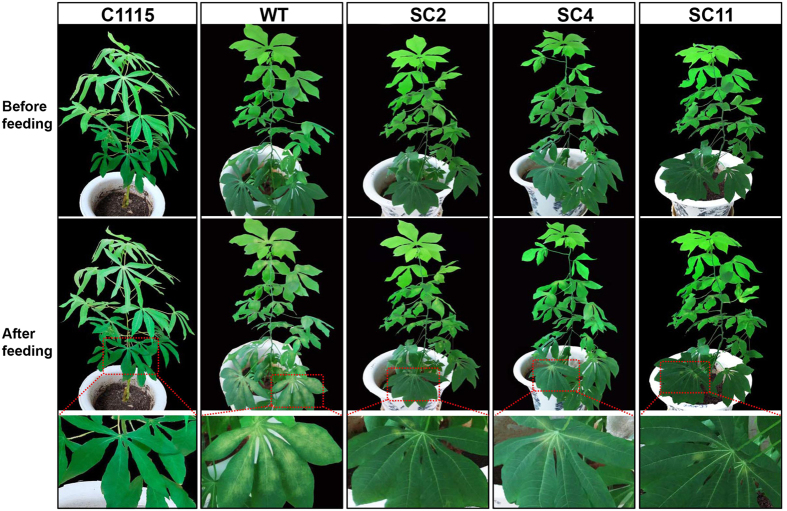
The symptoms in 3-month-old transgenic cassava lines damaged by T. cinnabarinus after 8 days in the laboratory.The bottom panels showed individual leaves. WT and C1115 were used as the mite-susceptible control and the mite-resistant control, respectively.